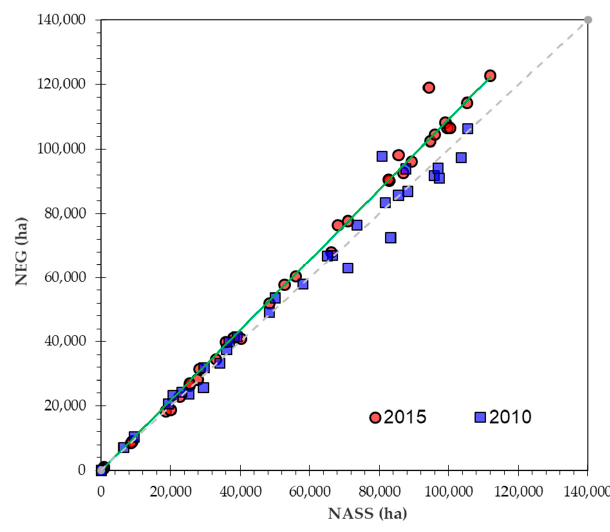
Figure 9. Regression between NASS and NEG irrigated area by county for 2010 and 2015.